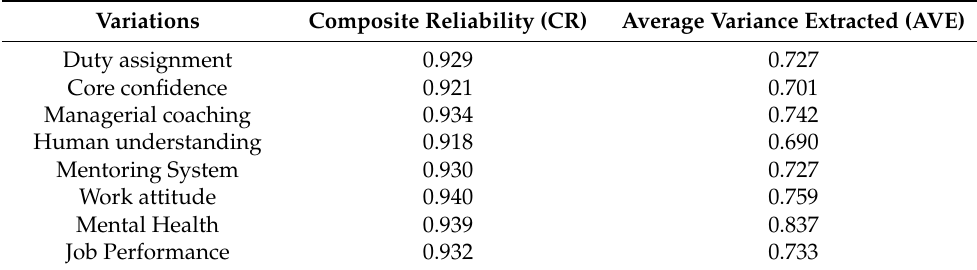
Table 3. Convergence Feasibility Validation.